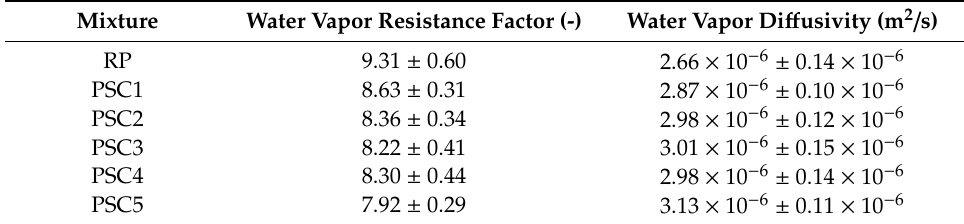
Table 6. Water vapor di ff usion properties of studied